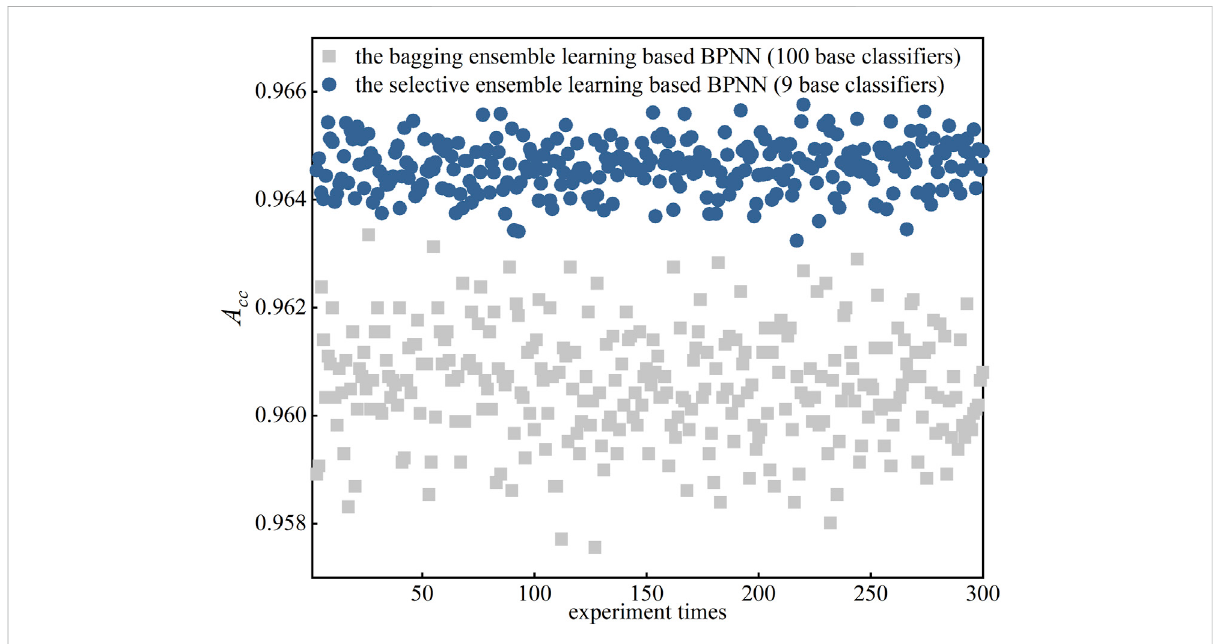
FIGURE 7 A comparison of the stability of two ensemble learning